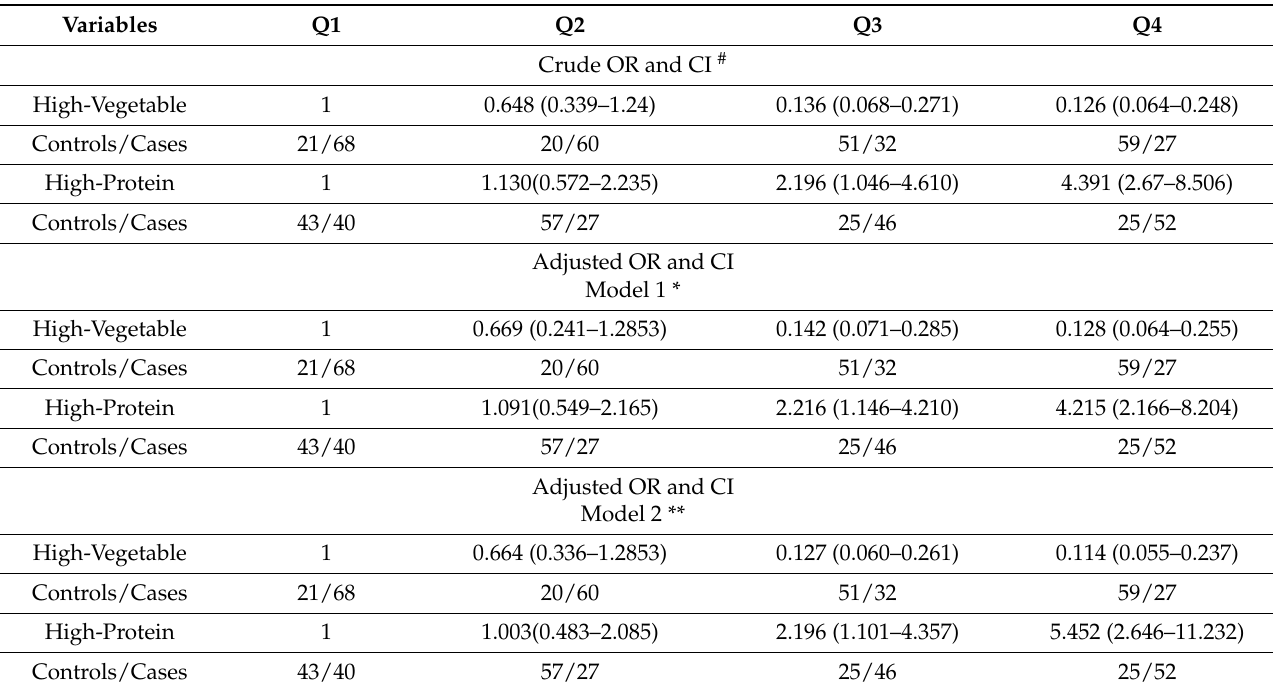
Table 3. Association between IBD risk and dietary patterns among the IBD ( n = 185) and controls ( n =